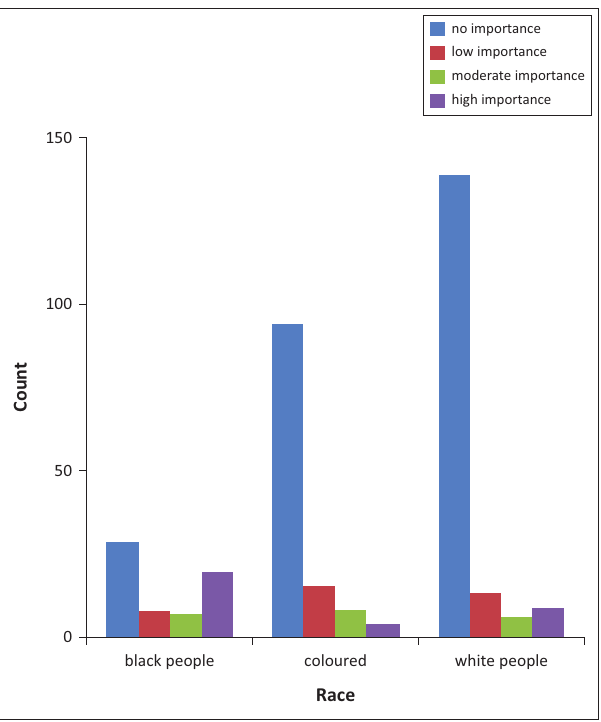
FIGURE 2: Graph illustrating response to ‘I received funding ...’ by